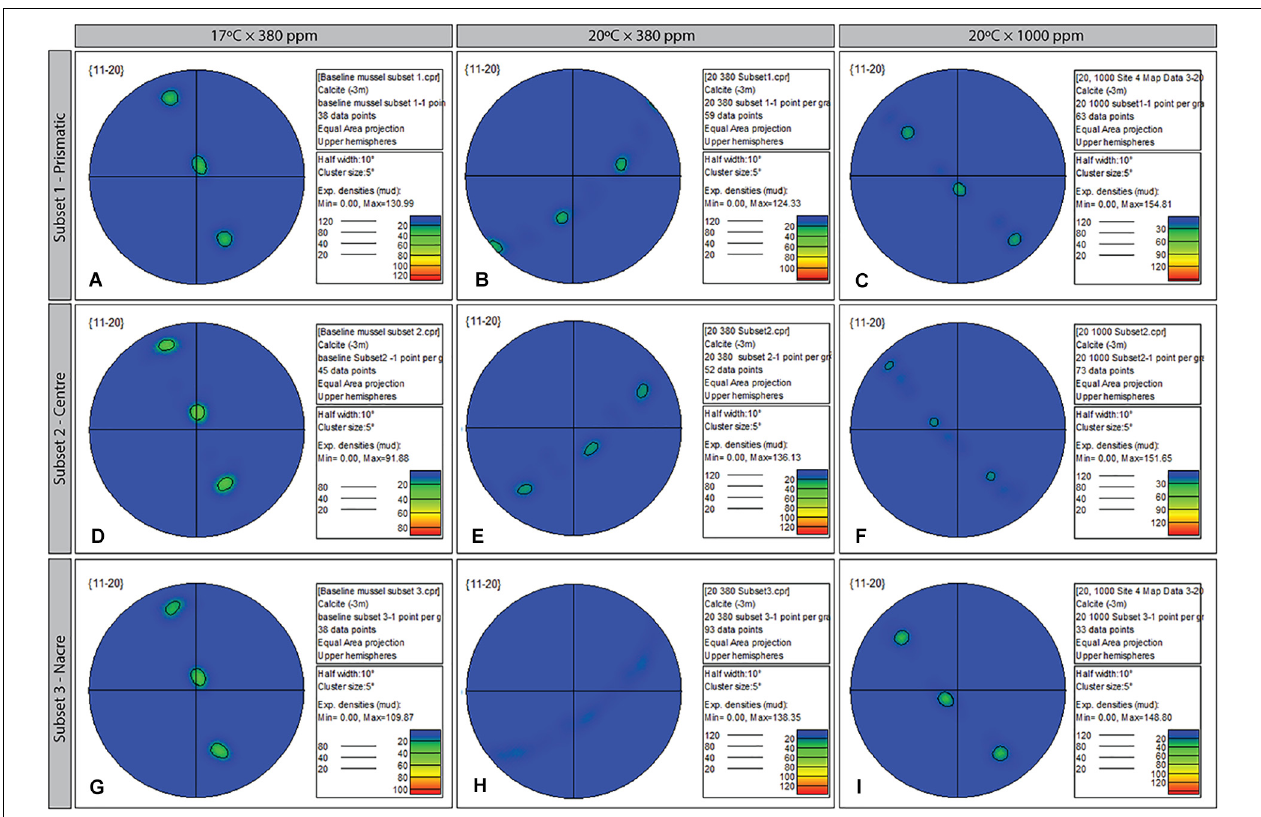
FIGURE 7 | Contoured pole figures (1 point per grain analysis) showing variation in crystallographic orientation along the 11-20 crystal plane in three regions (prismatic; center; and nacreous layers) of the ultrastructure of Mytilus sp. grown for 8-week under three climate scenarios: Control (A,D,C) ; Elevated Temperature (B,E,H) ; and Elevated Temperature and pCO 2 (C,F,I) . The MUD value for the three treatments varies from 98.64 (baseline, 17 × 380) to 154.81 (subset 1, 20 ×